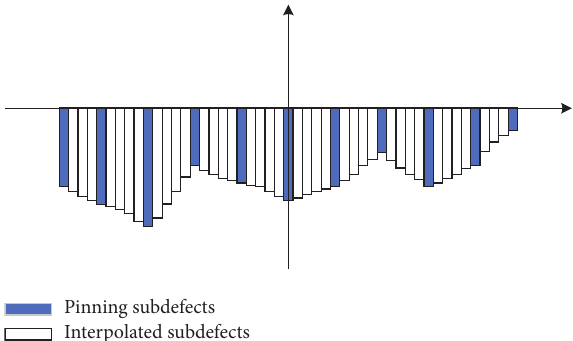
Figure 5: Illustration of pinning-based depth reconstruction within the ROI.